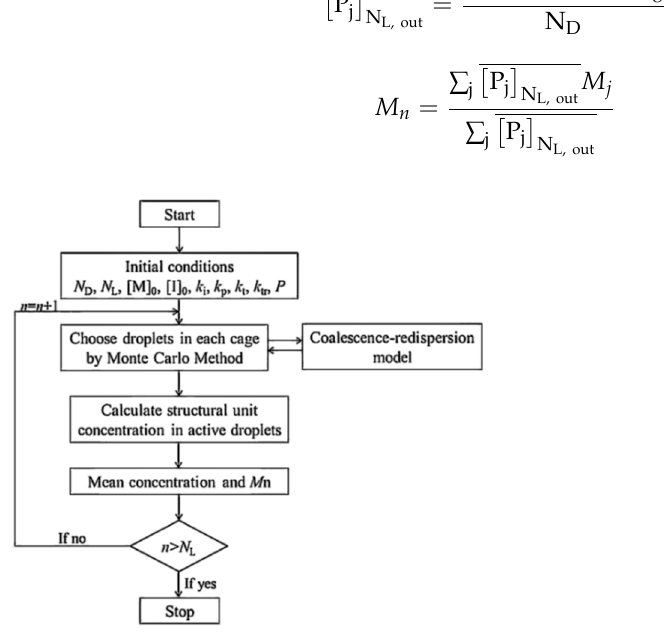
Figure 2. Simulation flow chart for the models.